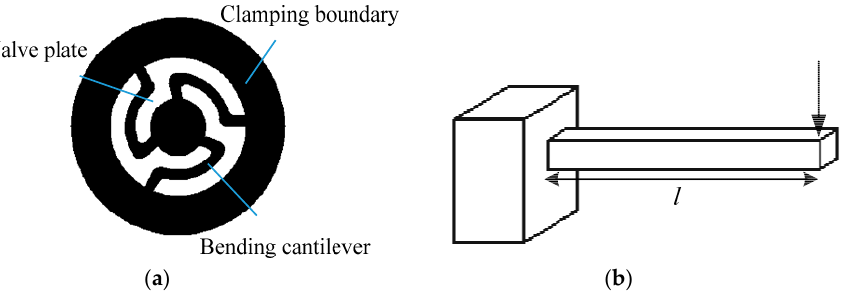
Figure 6. Opening and force for the inlet valve.